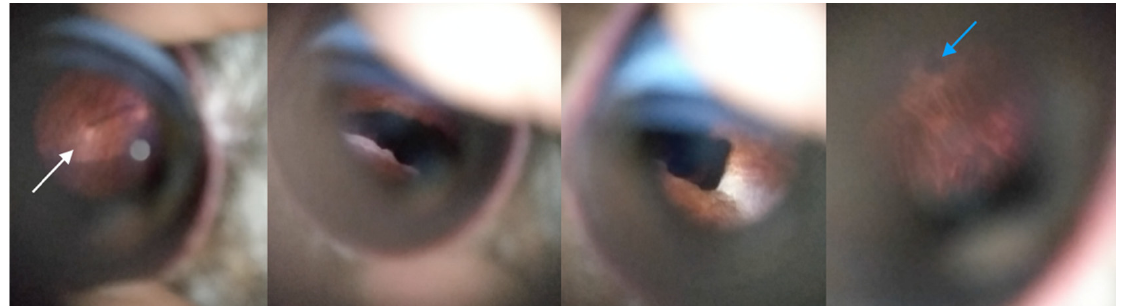
Figure 4. Fundus of a tawny owl ( Strix aluco ) showing a hypopigmented zone (white arrow) and a hyperpigmented zone (blue arrow). Sequellae of trauma were suspected. This fundus examination was classified as satisfactory.